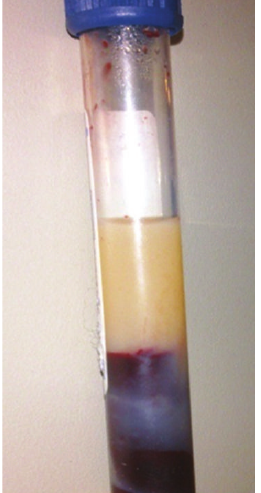
Figure 2: Lipemic serum of